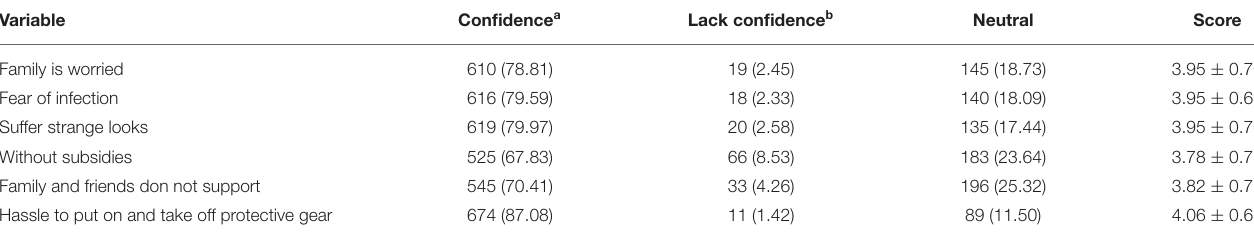
TABLE 4 | Respondents’ self-efficacy of caring for COVID-19 patients.